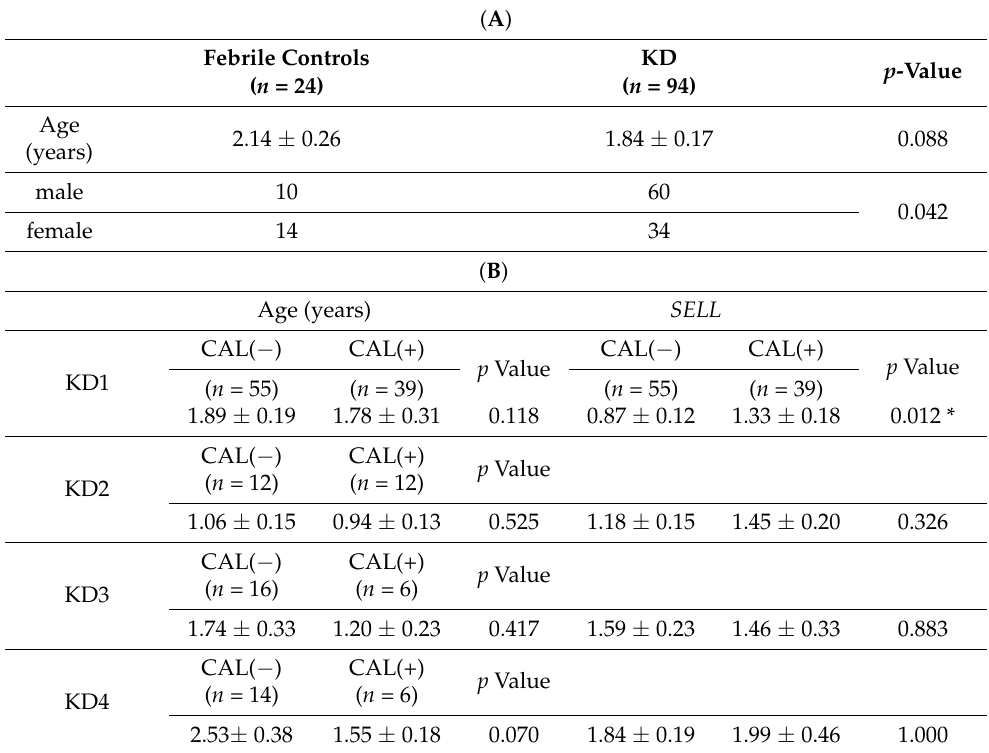
Table 3. ( A ) Demographic characteristics of the subjects with Kawasaki disease (KD) for SELL mRNA; ( B ) SELL mRNA levels between patients with and without coronary artery lesions (CAL).